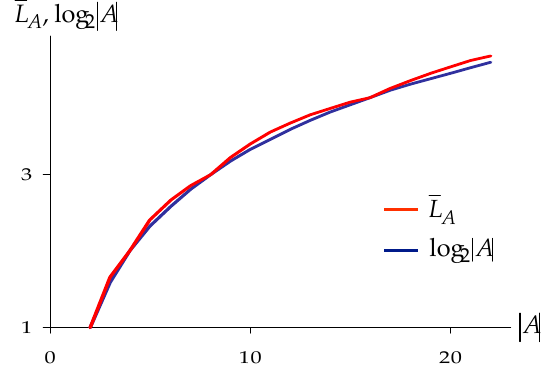
| A | on | A | A log A L 2 2 and on .